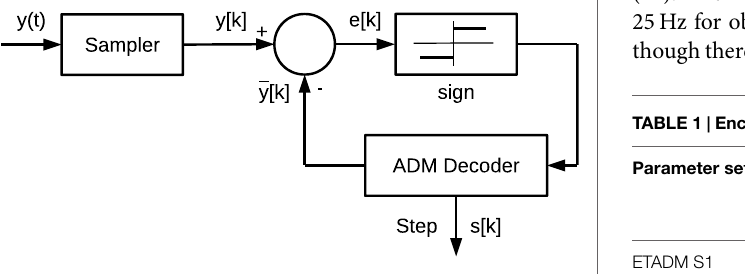
FIGURE 6 | Schematic of the ADM encoder .